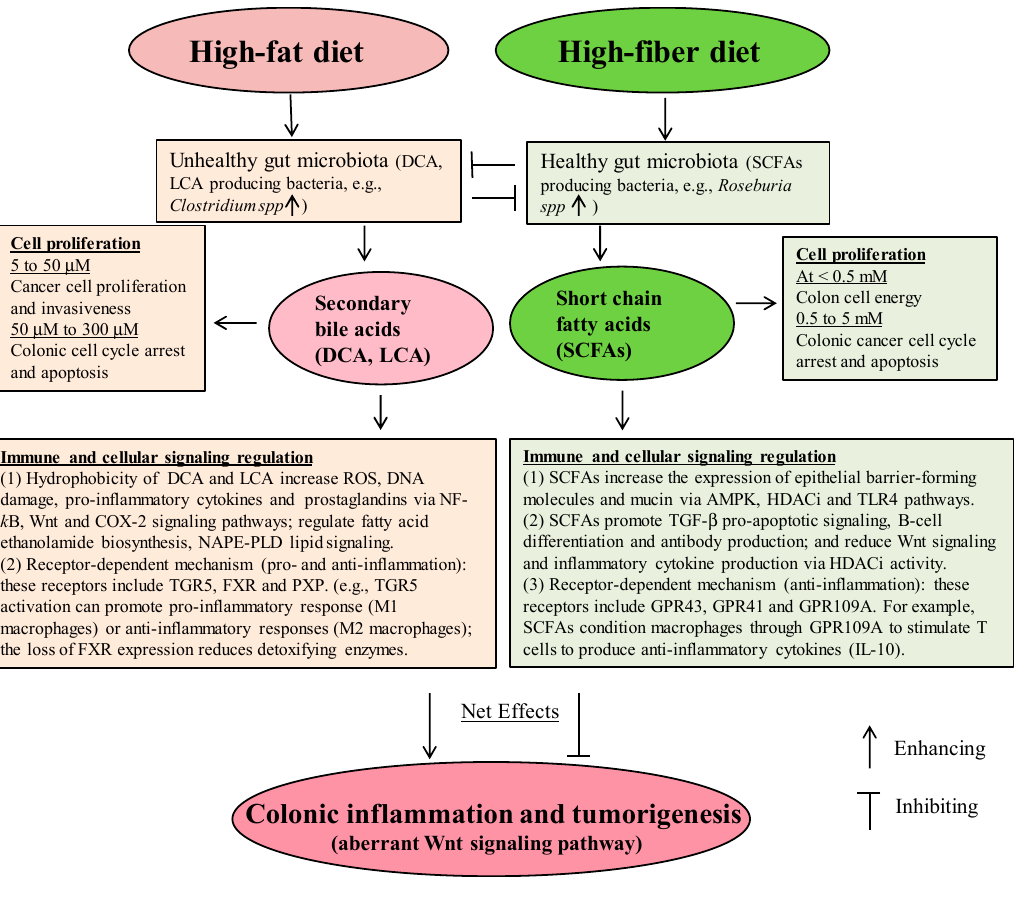
Figure 2. The proposed interaction of primarily functional pathways related to secondary bile acids (BAs) and short chain fatty acids (SCFAs) in the colon.